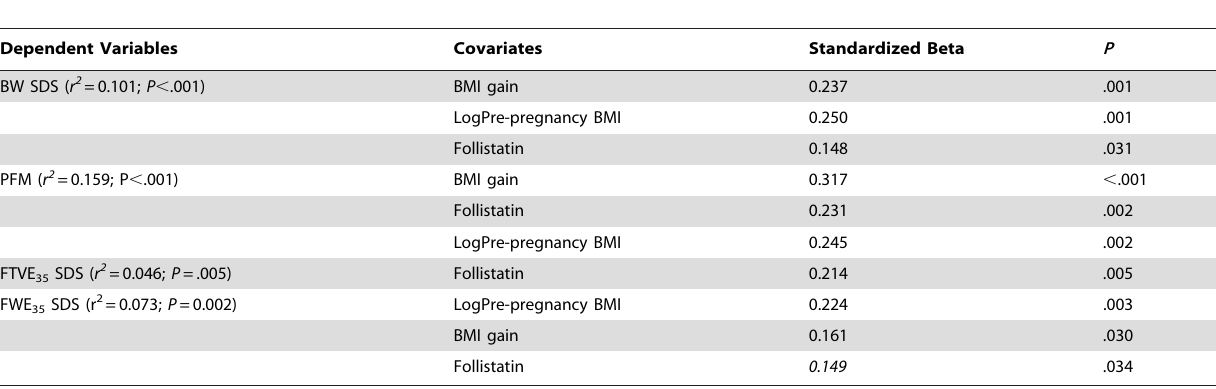
Table 3. Stepwise multiple linear regression models of anthropometrical and ultrasound